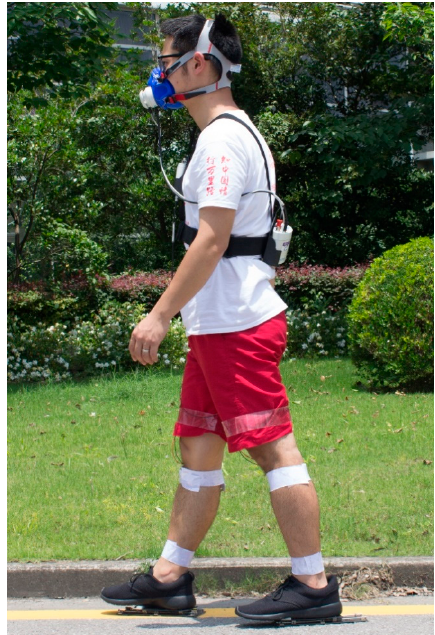
Figure 2. Experimental setup. Subjects performed 200 m normal and fast walking trials on flat ground